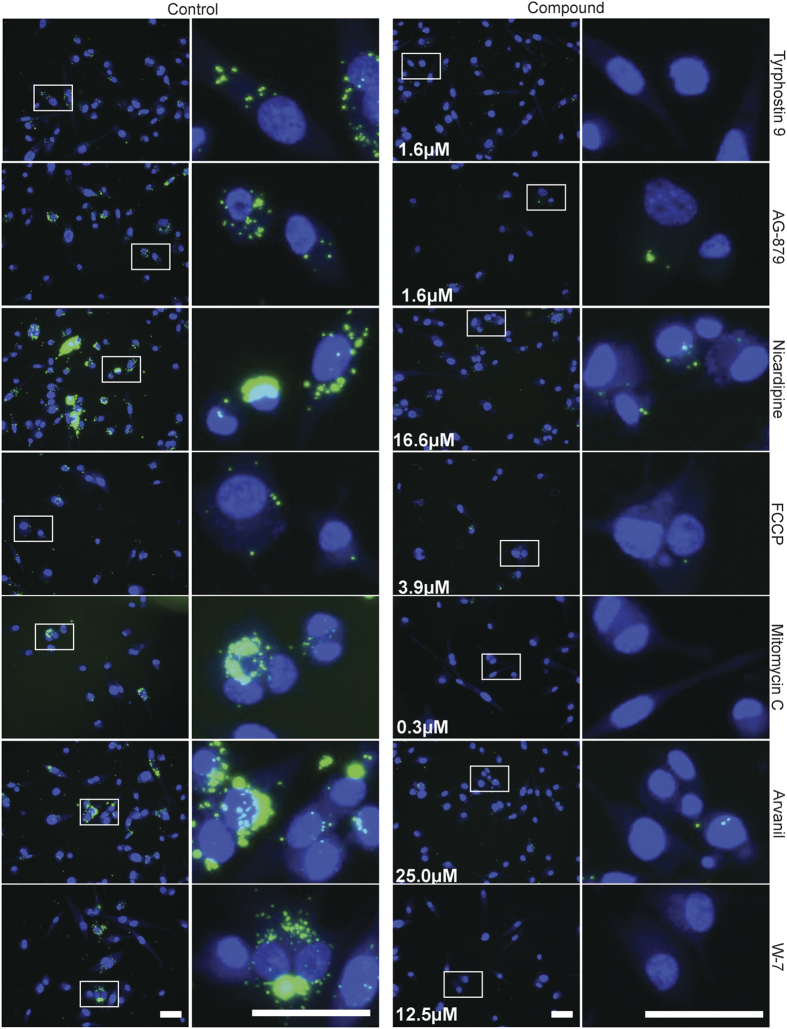
Inhibition of B. abortus replication in THP-1 cells at MIC. Images of B. abortus (green pseudocolor) and Hoechst-stained THP-1 nuclei (blue) of cells treated with compunds at their respective minimum inhibitory concentrations (MICs). The images were taken 72 hours post-infection. Control column represents mock treated controls matching each treatment in the Compound column. Magnified inset regions (white box) appear to the right of each image. Scale bars = 50 μm.